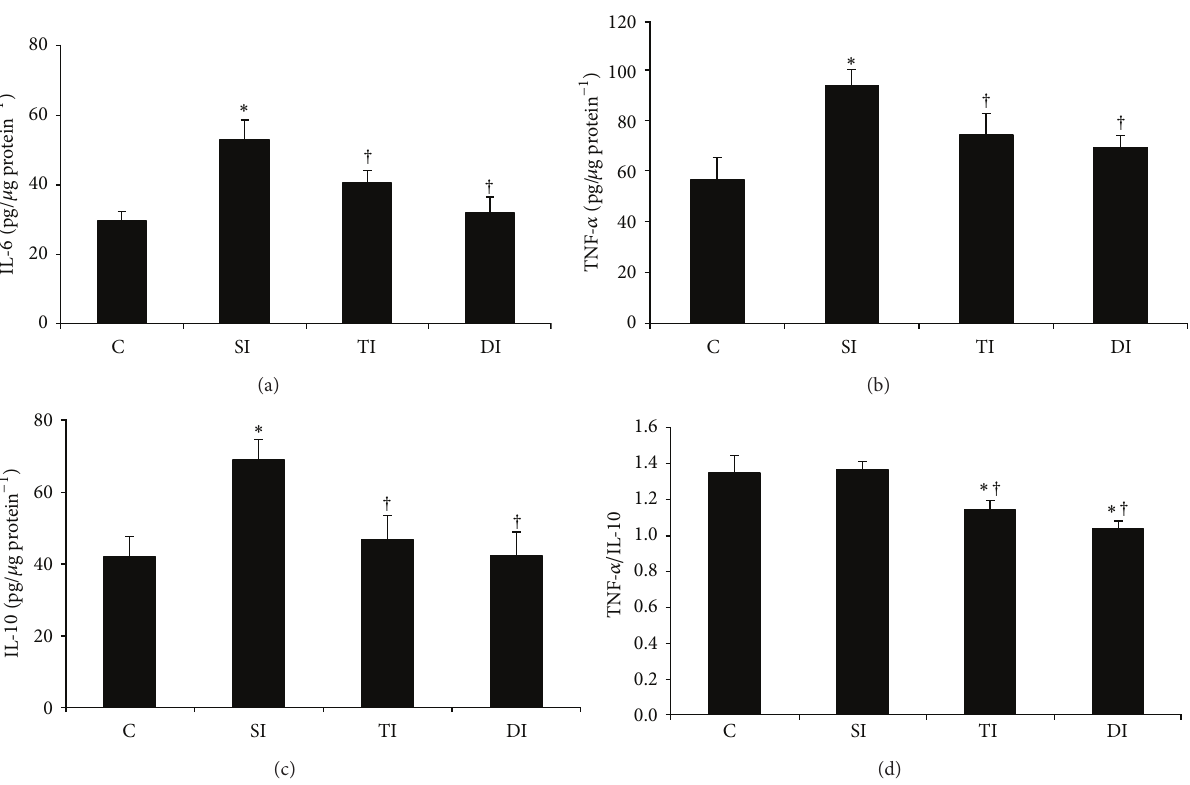
Figure 2: Left ventricle inflammatory profile in control (C), sedentary infarcted (SI), trained infarcted (TI), and detrained infarcted (DI) rats. ∗ 𝑃 < 0.05 versus C; † 𝑃 < 0.05 versus